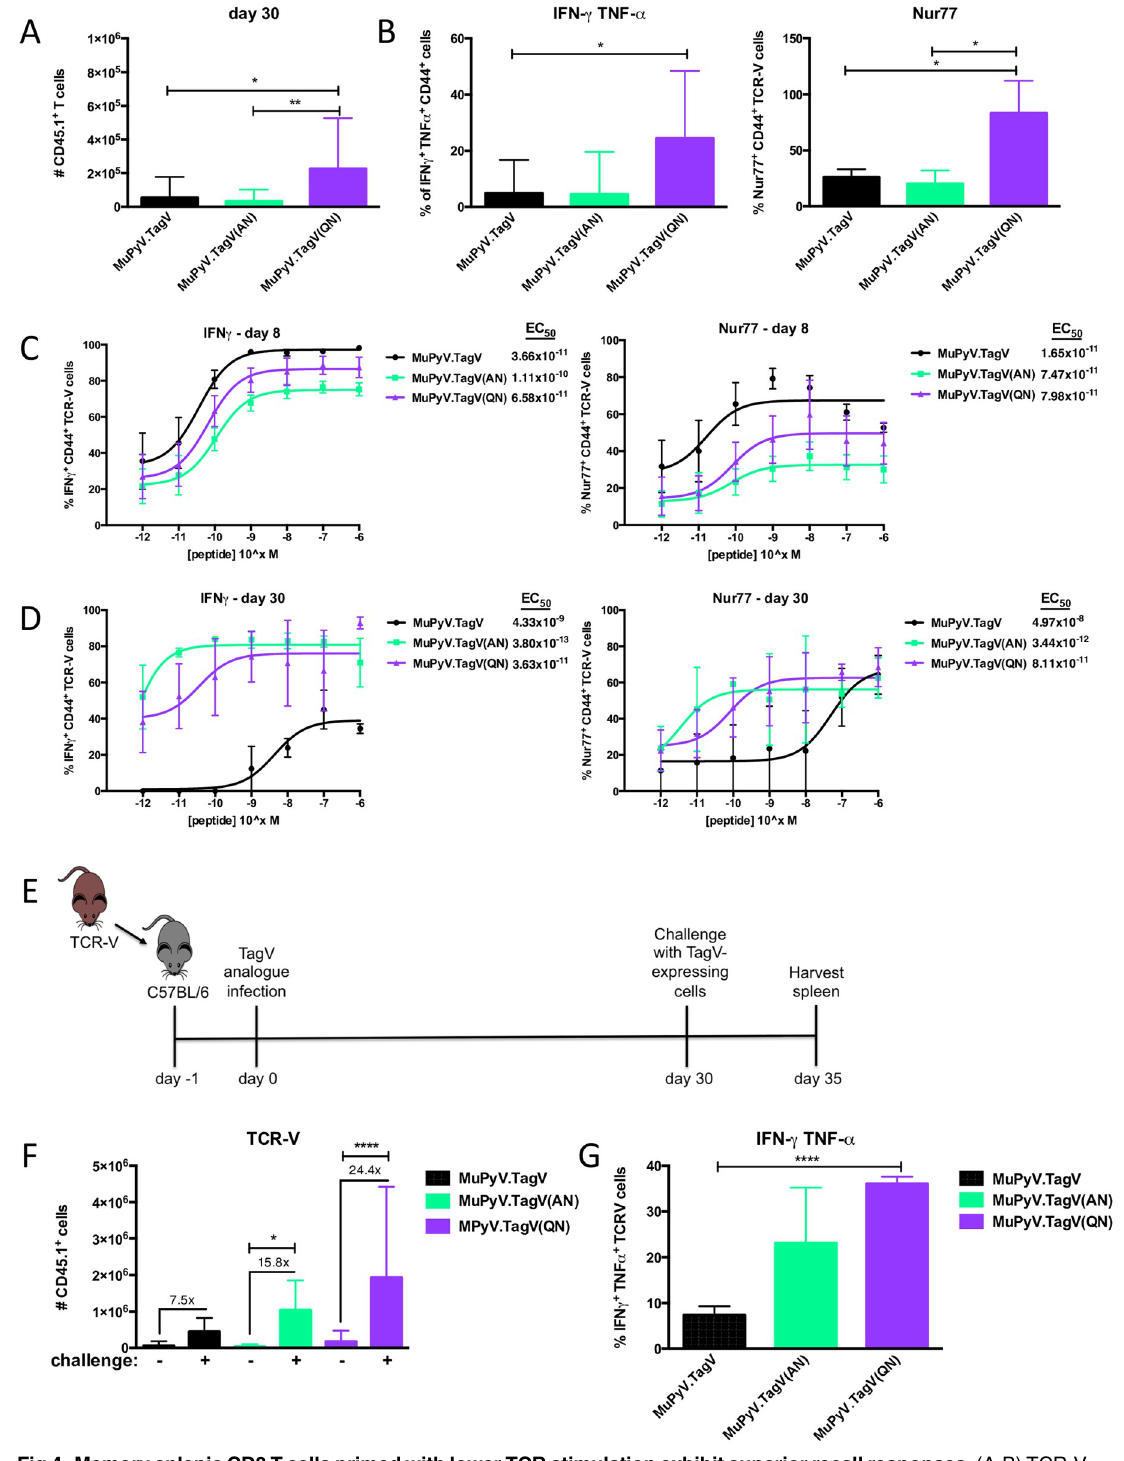
Fig 4. Memory splenic CD8 T cells primed with lower TCR stimulation exhibit superior recall responses. (A-B) TCR-V cells were adoptively transferred into B6 mice one day prior to infectionwith cognateTag V or TagV analogueviruses, then sacrificedat day 30 p.i. (A) Number of TCR-V cells in the spleen.(B) IFN γ and TNF α co-expression (left panel)and Nur77 expression(right panel)in splenocytesstimulated for 5 h ex vivo with 1 μ M TagV peptide. (C-D) Intracellular IFN γ (left panel)and Nur77 (right panel)expressionby TCR-V cells isolatedfrom the spleen at day 8 p.i. (C) or day 30 p.i. (D) stimulatedfor 5 h ex